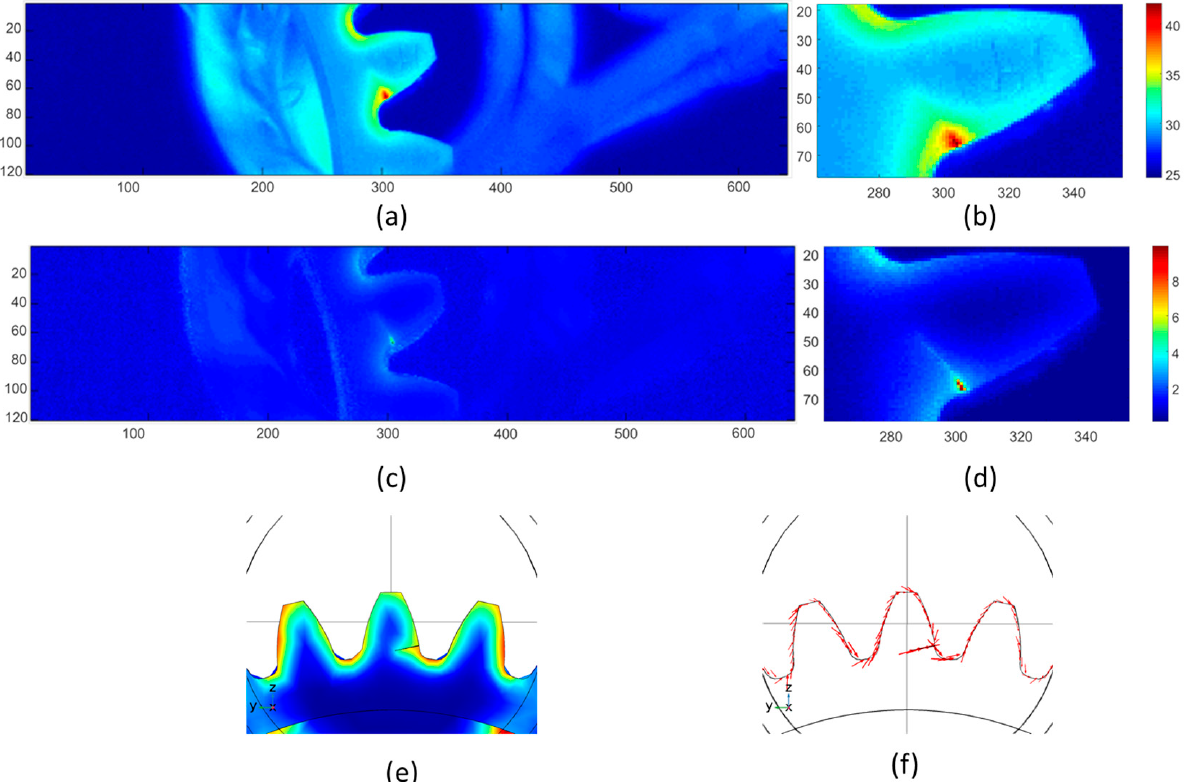
Figure 5. Thermal pattern reconstruction for fault detection in gears. ( a ) Raw data from thermography of failed gear tooth. ( b ) Enlarged image. ( c ) Emissivity corrected the thermal pattern of the gear. ( d ) Detailed failure distribution on the failed tooth. ( e ) Model design in COMSOL, Temperature responses at gear teeth, ( f ) Eddy current distribution.